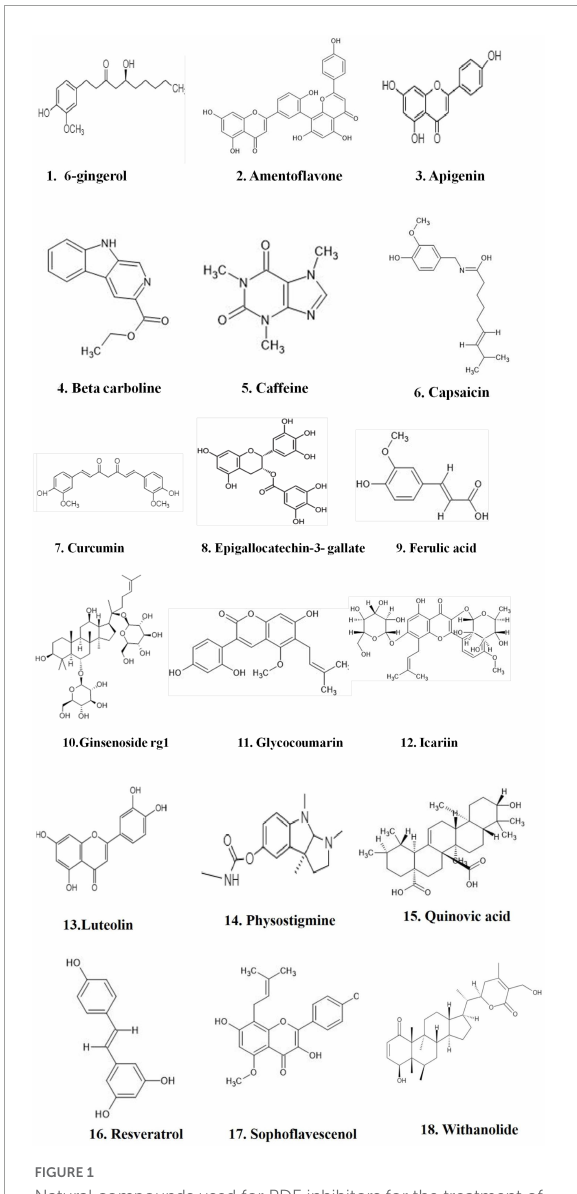
FIGURE1 Natural compounds used for PDE inhibitors for the treatment of AD. The figure is original and generated by Bio-render